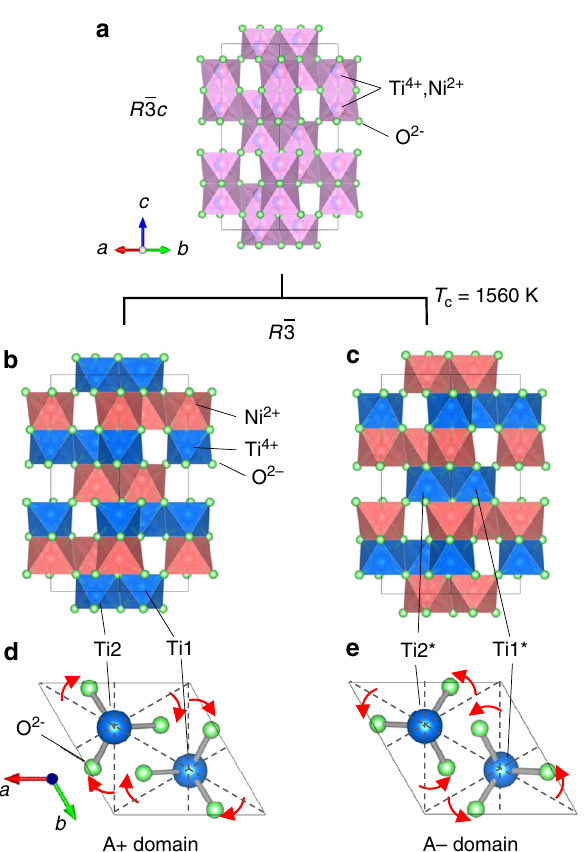
Fig. 2 Order-disorder phase transition and formation of ferroaxial domains in NiTiO 3 . a The crystal structures of NiTiO 3 a above and b , c below the ferroaxial transition temperature ( T c ≈ 1560 K). The crystal structure above T c belongs to a non-ferroaxial space group ( R (cid:1) 3 c ) and is described by a disordered corundum structure with a random distribution of Ni 2 + and Ti 4 + ions at cation sites. With lowering temperature, cation ordering takes place at T c and results in a structural phase transition into an ordered ilmenite structure with a ferroaxial space group ( R (cid:1) 3). Below T c , thus, a pair of ferroaxial domain states with the opposite rotation direction, i.e., the opposite sign of axial vector A , are present (A + and A − domains). d , e The c -axis views of the ferroaxial domains. Only two Ti ions [Ti1 (*) and Ti2 (*) ] and six oxygen ions are depicted. These ions form two TiO 3 triangular pyramids which are related by the space inversion with the inversion center at the midpoint between Ti1 and Ti2 ions. Red arrows denote the direction of rotational displacements of oxygen ions from the (110)-type planes (dotted lines) that correspond to the average oxygen positions between A + and A −